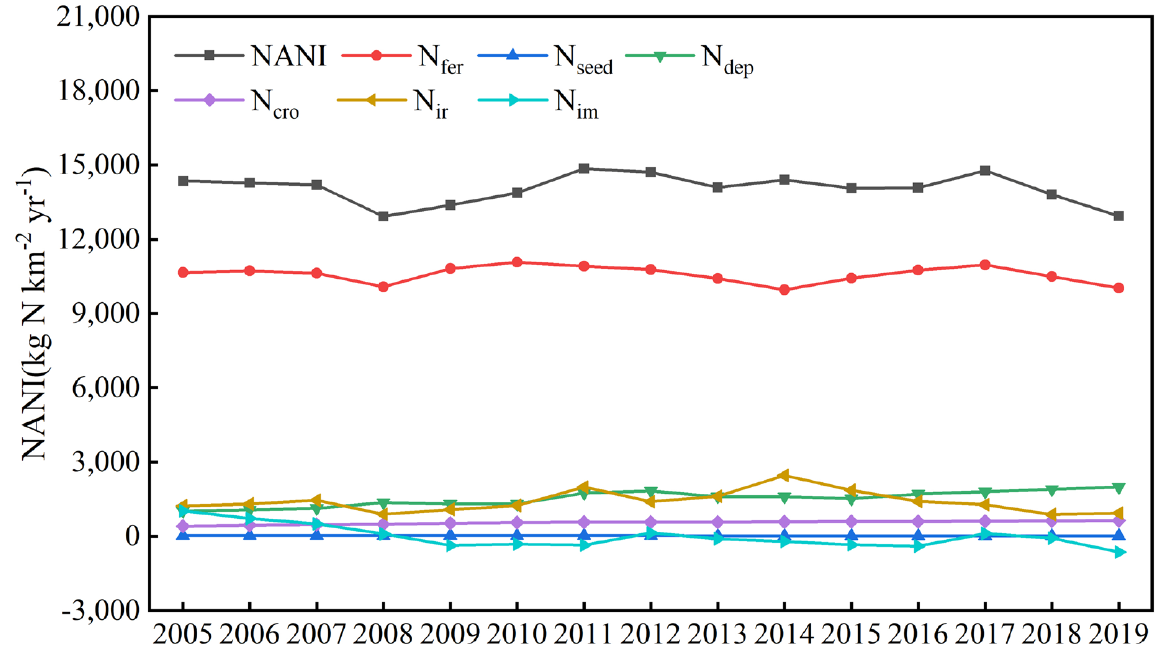
Figure 4. Temporal changes of NANI and NANI from fertilizer N input (N fert ), irrigation N input (N ir ), atmosphere N deposition (N dep ), seed N input (N seed ), Nitrogen fixation (N cro ), and net food and feed N input (N im ) during 2005 − 2019 in the UNW.